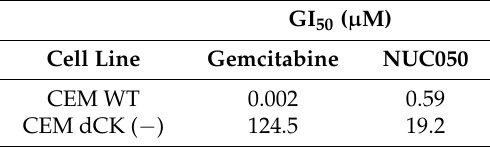
Table 3. Comparison of GI 50 of gemcitabine and NUC050 in CEM WT cells and cells deficient in